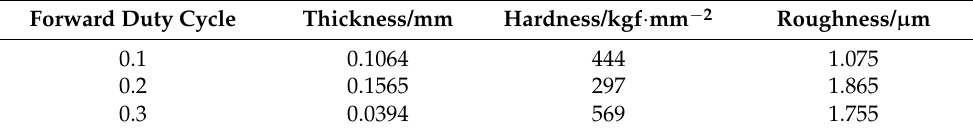
Table 4. Results of the effect of forward duty cycle on the performance of composite plating.